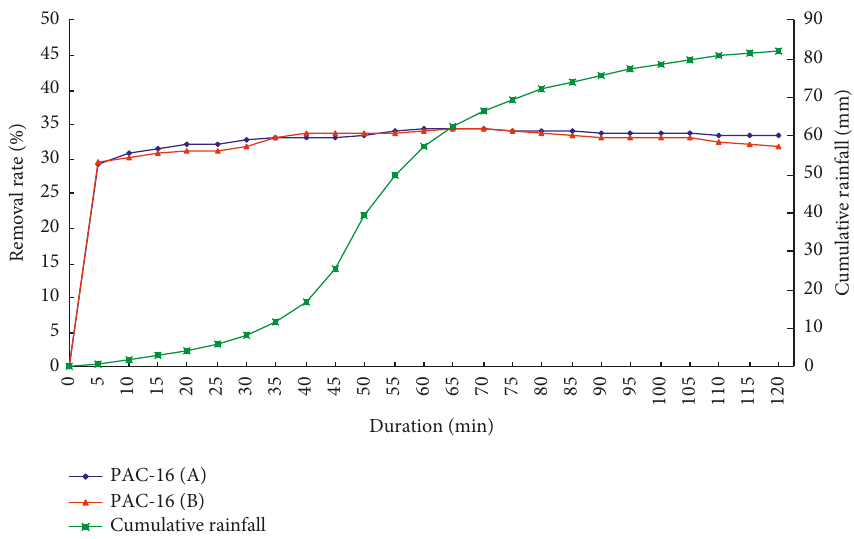
Figure 8: The removal rate of Pb(II) for PA specimens with different AV Table 7: Correlations between removal rate of Pb(II) and parameters for characterizing voids in both. Removal rate